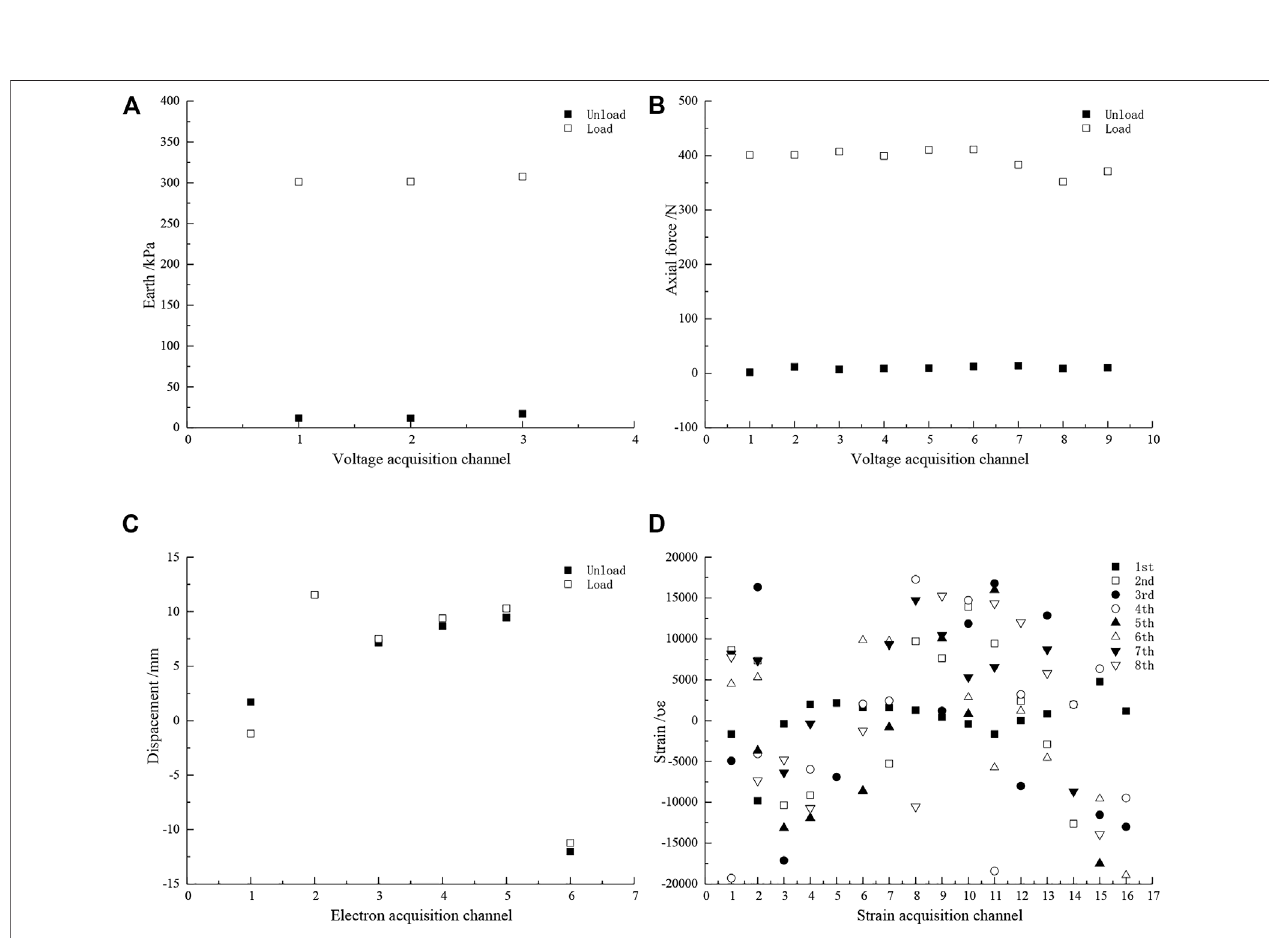
FIGURE 8 | Data of static pressure model test: (A) earth pressure, (B) axial force, (C) displacement, and (D) strain.